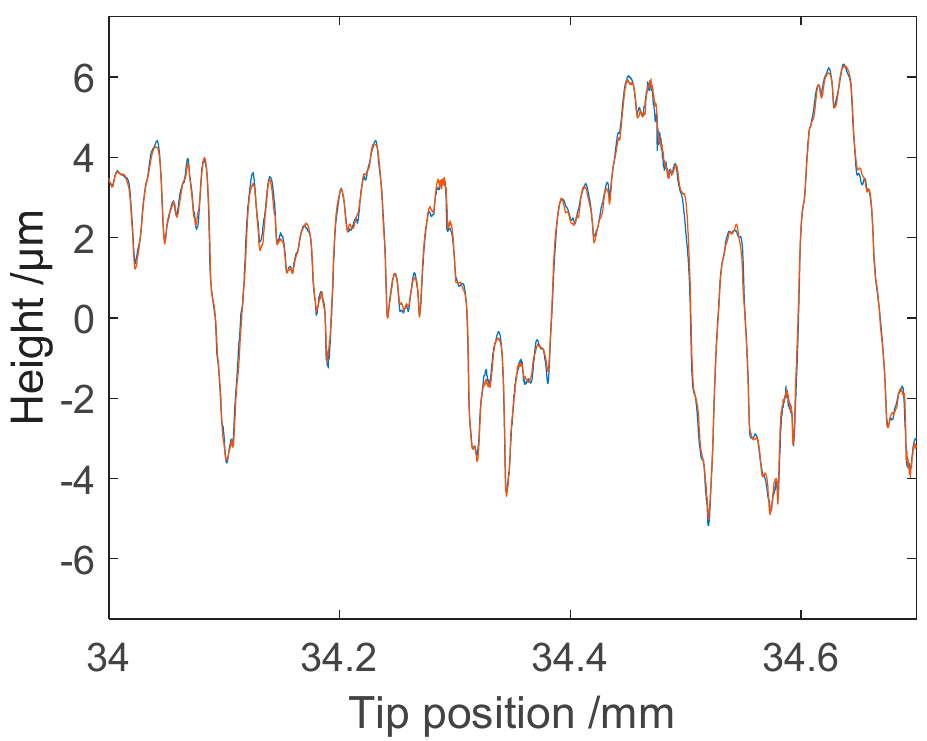
Figure 12. Enlarged detail of Figure 11 showing the repeatability of two consecutive measured profiles.